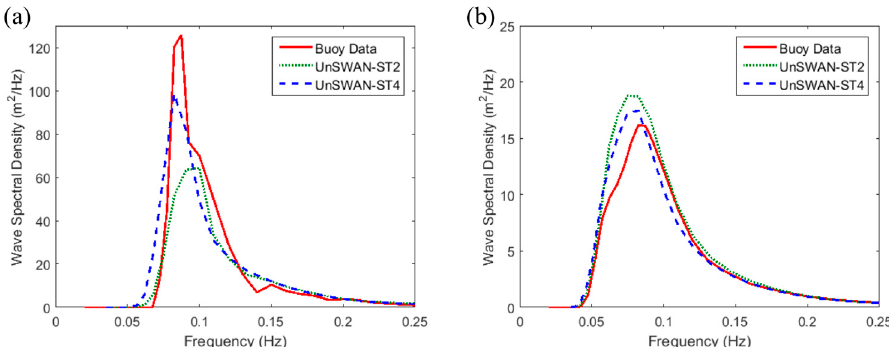
Figure 5. Measured and modeled wave spectra at NDBC Buoy 46050 ( a ) at 5 a.m. on 17 November 2009; and ( b ) the November monthly average, 2009.